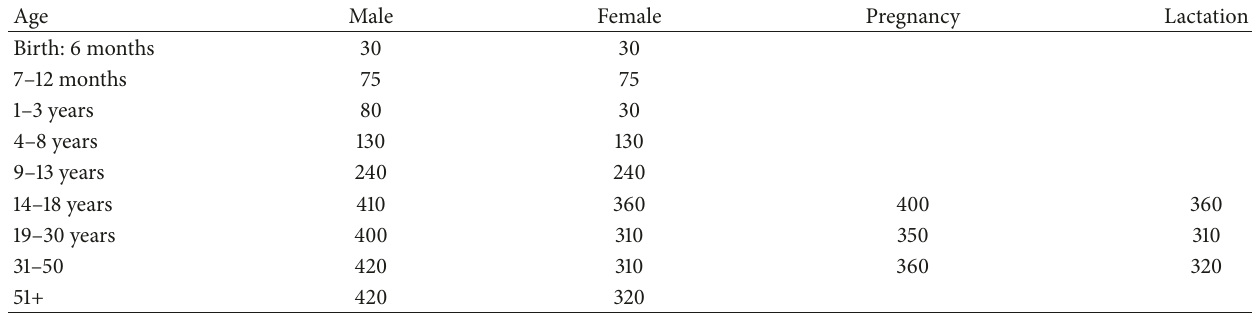
Table 3: Recommended dietary allowances (RDA) for magnesium in mg [15].